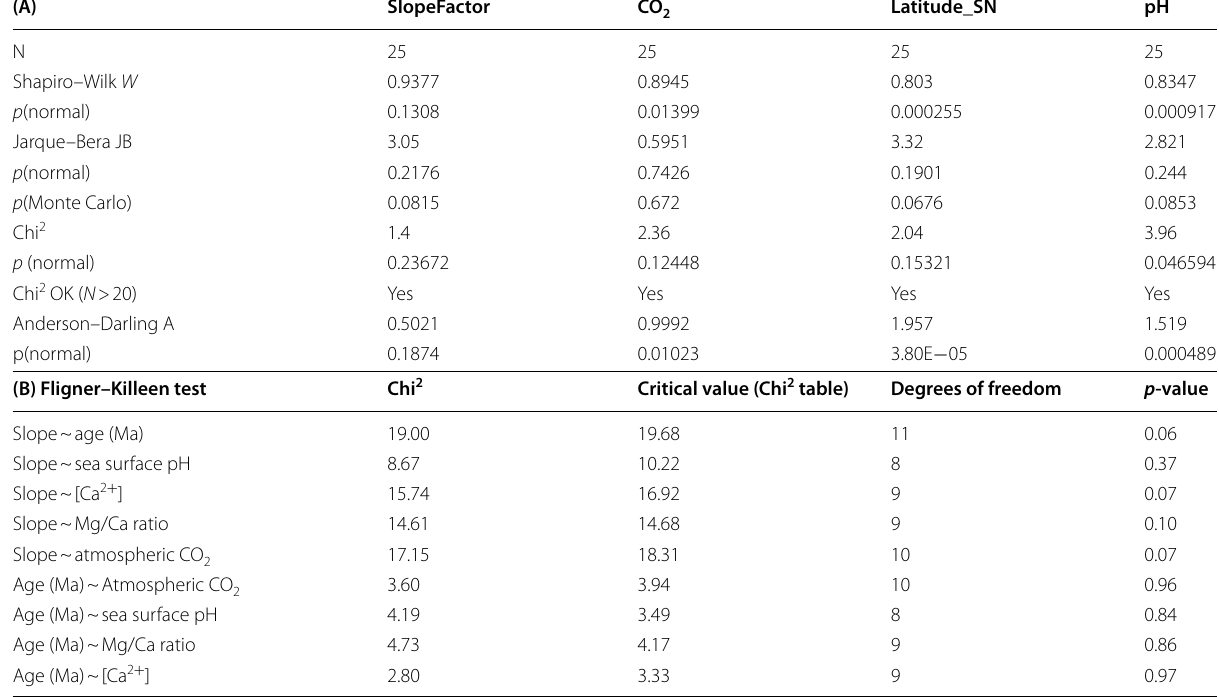
Table 3 Matrices with results of tests for normality of the data produced using PAST (A, top) and including R-output of the Fligner– Killeen test (B, bottom) of homogeneity of variances (slope is short for septal slope